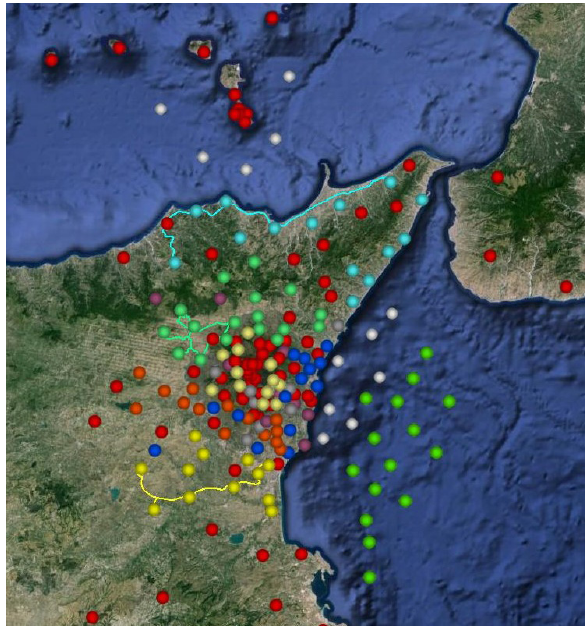
Figure 17. Final map of the deployed stations, different colours rep- resent the deployment teams that were in charge of them. Red dots are the stations from the permanent network of the INGV. Yellow dots are stations for the South-Catania team; dark-blue dots for the East-Catania team, orange dots are West-Catania team; light yellow dots are Etna-team; grey and purple dots are INGV-technicians team; light green dots are Randazzo team; light blue are Villafranca team; green dots are the Spanish OBSs; and white dots are the Ital- ian OBSs. Coloured-lines show some examples of daily team routes (>200 km